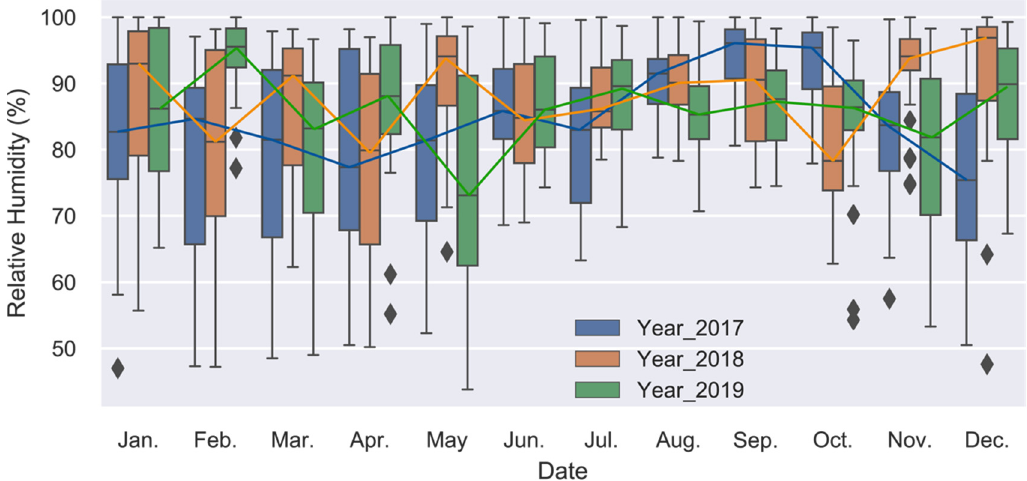
Figure A4. The distribution of maximum daily relative humidity for three years.